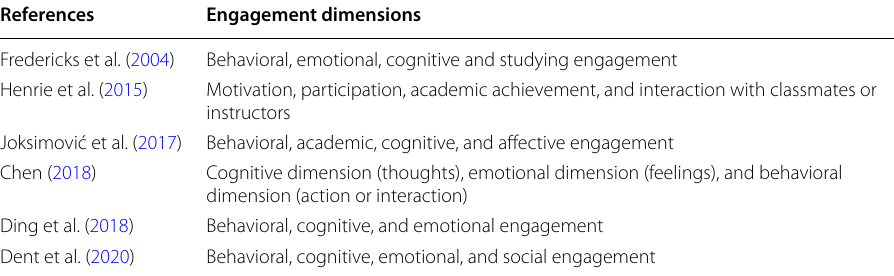
Table 2 Summary of learner engagement